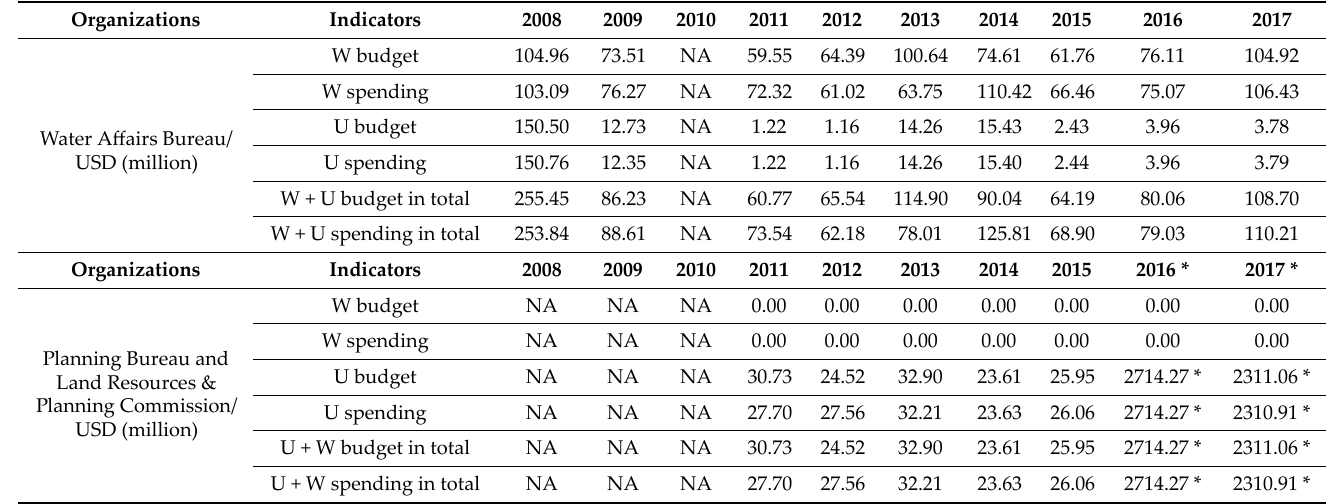
Table1. Budgetandspendingrelating tofloodingissues oftheWaterAffairBureau,